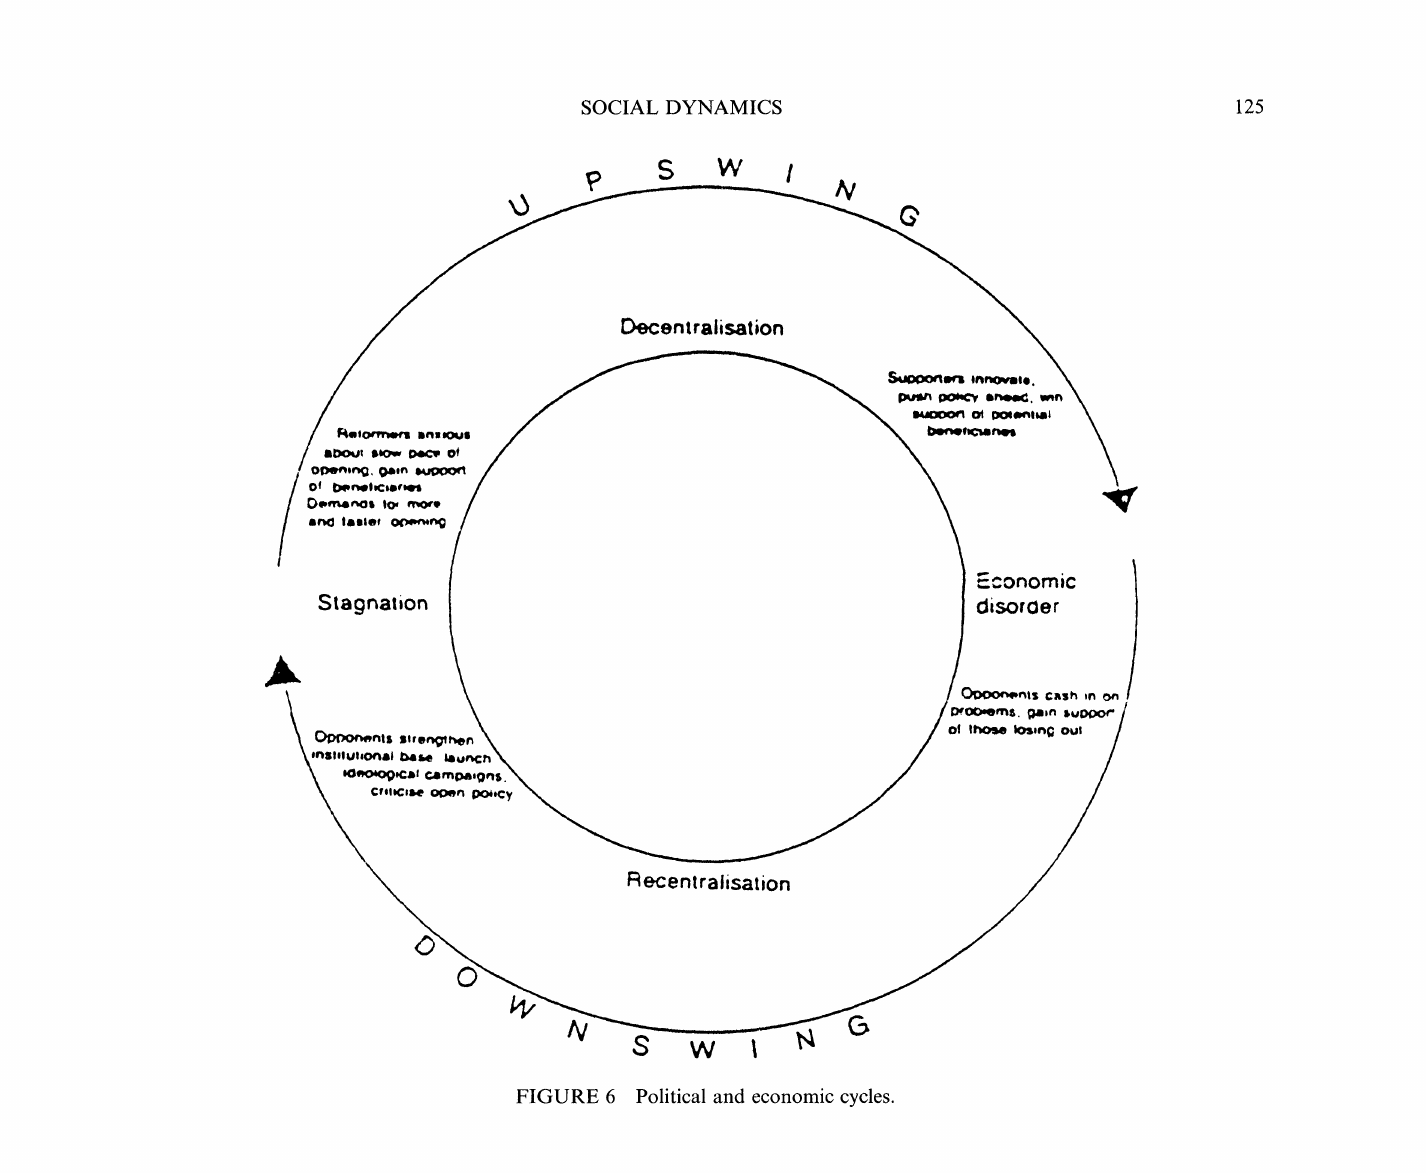
FIGURE 6 Political and economic